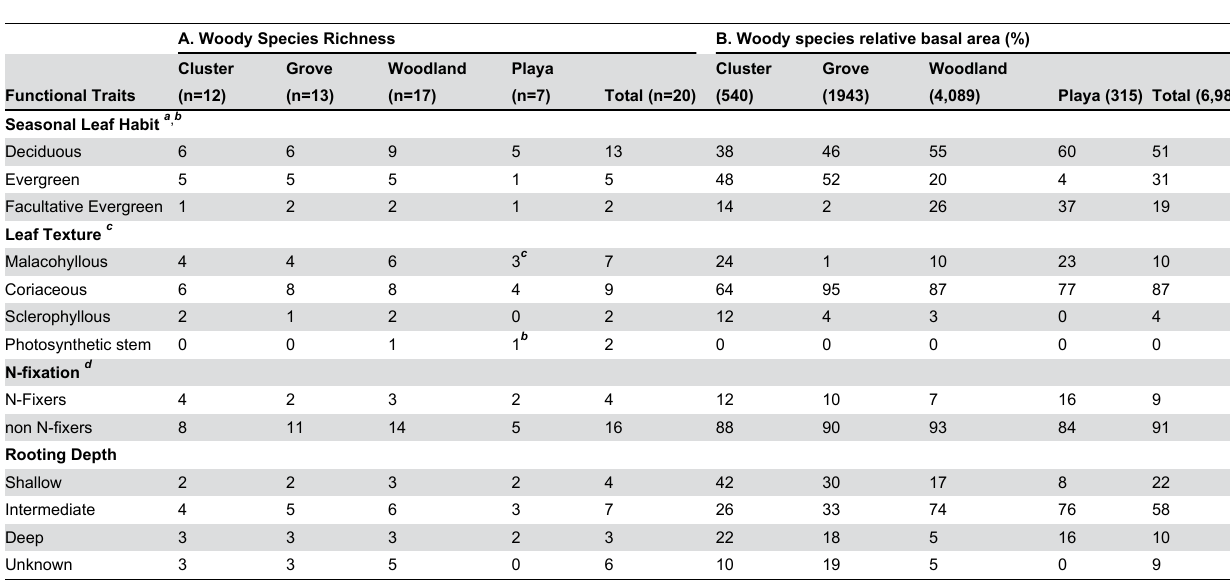
Table 4. Woody species functional groups and their relative basal area along the